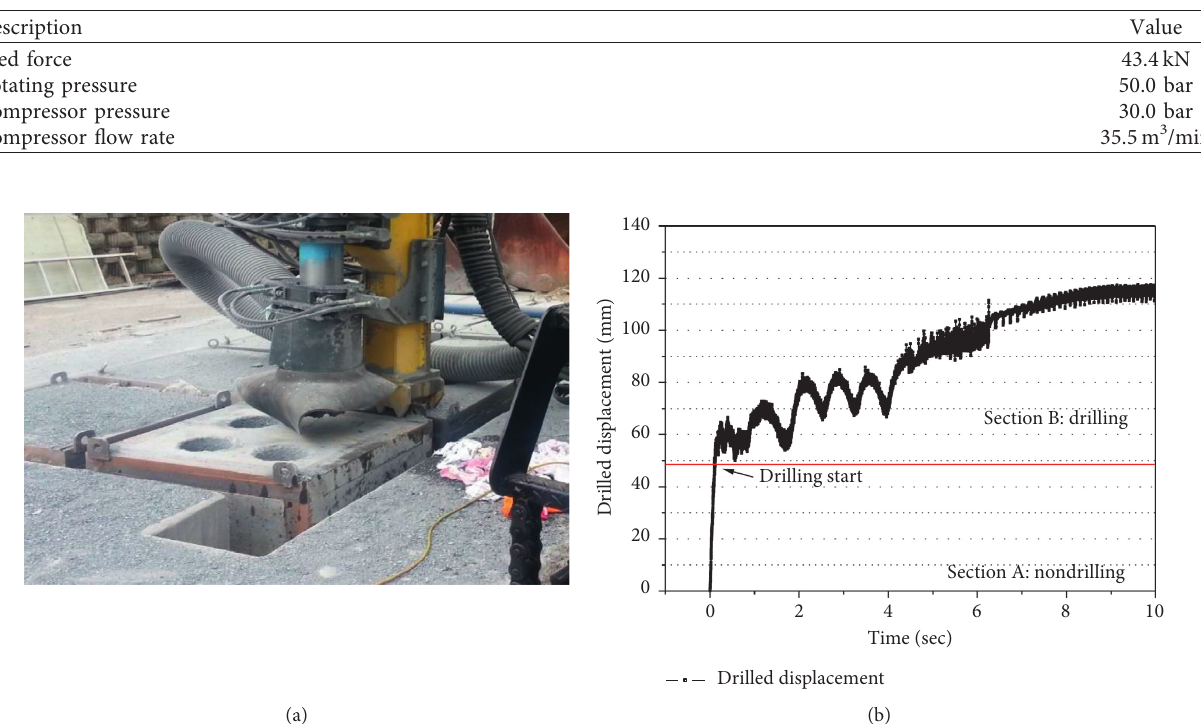
Figure 15: In situ drilling tests: (a) concrete mass to be drilled and (b) percussive rock drilling system. Table 6: Operating conditions of the DTH drilling system.